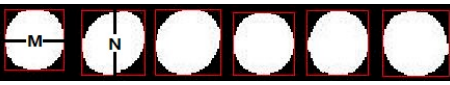
Figure 6. The horizontal and vertical distances.